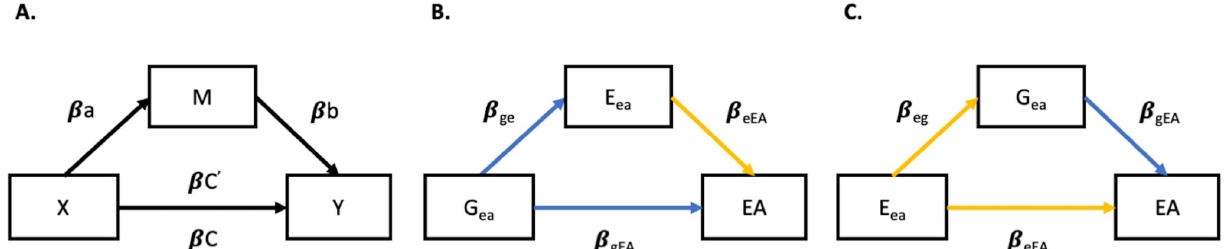
Fig 4. Panel A = schematic representation of mediation analysis; β C = effect of a predictor X on an outcome Y; β a = effect of X on a mediator (M); β b = effect of M on Y after adjusting for X; β C’ = effect of X on Y after adjusting for M. Panel B = Directed acyclic graph (DAG) showing E ea mediated effects of G ea on EA in the hold out-set; β ge = causal path between G ea and E ea equivalent to r G,E ; β eEA = direct independent E ea effects on EA; β gEA = total G ea effects on EA. Panel C = DAG showing G ea mediated effects on EA (genetic confounding, see methods and discussion); β eg = causal path between E ea and G ea equivalent to r G,E ; β gEA = direct independent G ea effects on EA; β eEA = total E ea effects on EA. Note. Blue paths represent G model effects, yellow paths represent E model effects.